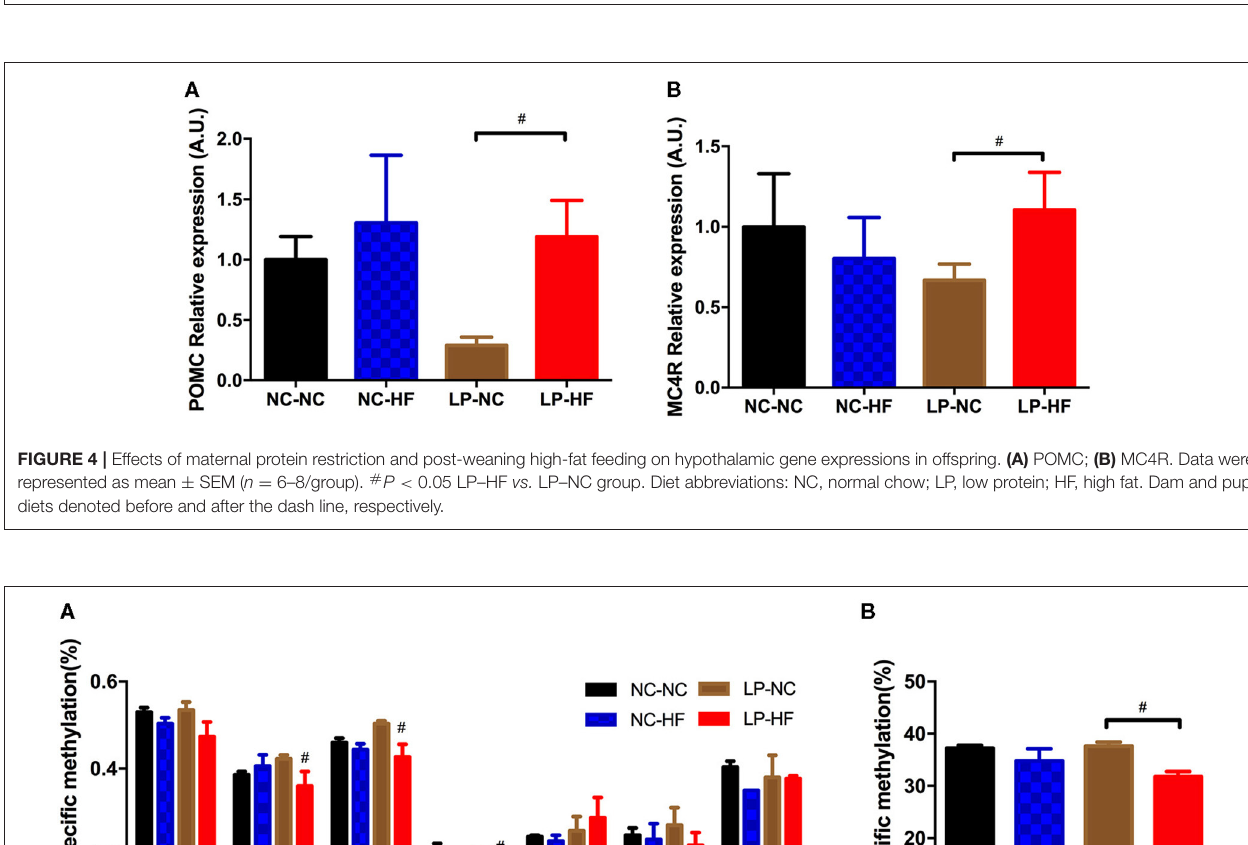
FIGURE 3 | Maternal protein restriction and post-weaning high-fat feeding predisposes offspring to hyperinsulinemia and hyperleptinemia. (A) Serum insulin level; (B) serum leptin level. Data were represented as mean ± SEM ( n = 6–8/group). P -value is significant as denoted. Diet abbreviations: NC, normal chow; LP, low protein; HF, high fat. Dam and pup diets denoted before and after the dash line, respectively. *** P < 0.001 NC–HF vs. NC–NC group. # P < 0.05 LP–HF vs. LP–NC group. ∧ P < 0.05 LP–HF vs. NC–NC group.